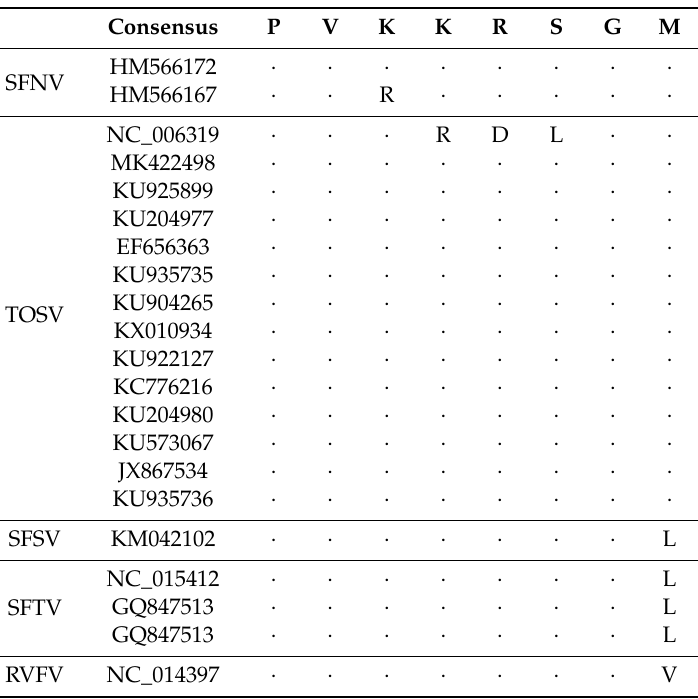
Table 1. L protein sequences of Toscana virus (TOSV) (amino acid positions 1599 to 1601) and sequences of related phleboviruses in this